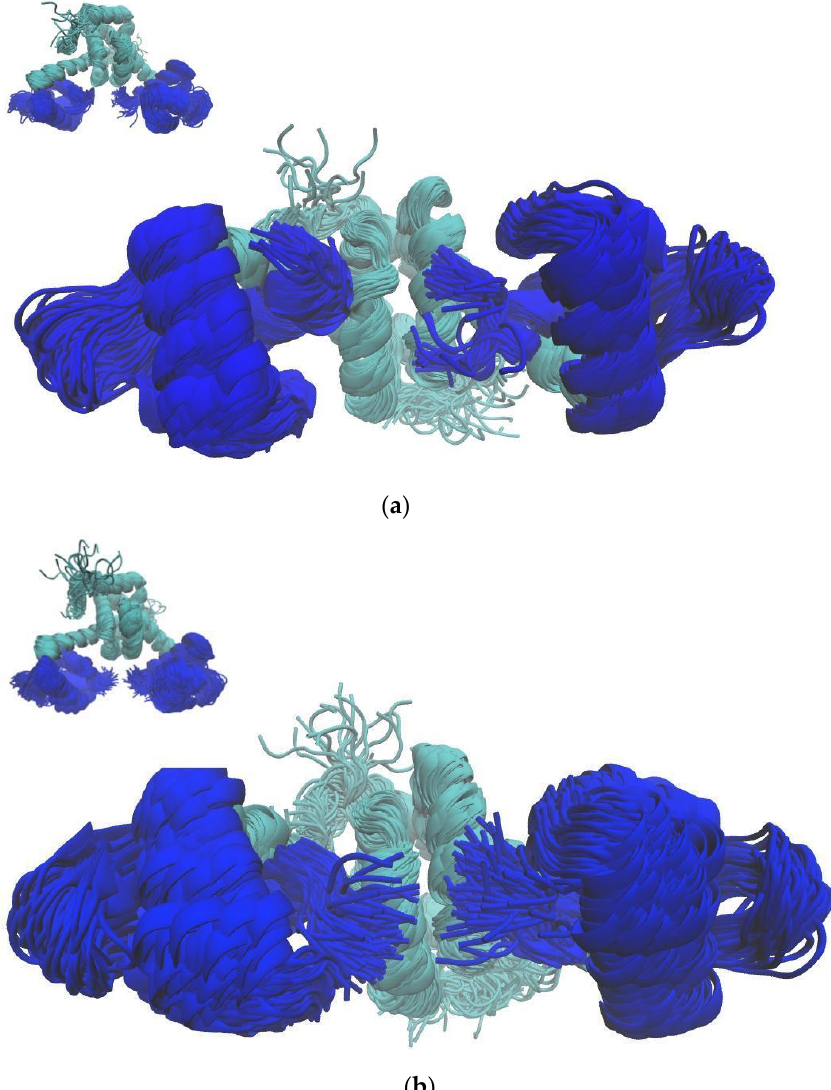
Figure 1. The superposition of snapshots taken every 5 ns during MD simulations of the MntR protein in ( a ) its Mn 2+ -bound form and ( b ) its apo state. Two different orientations of the protein are shown. DNA-binding domains (DBD) are colored blue.